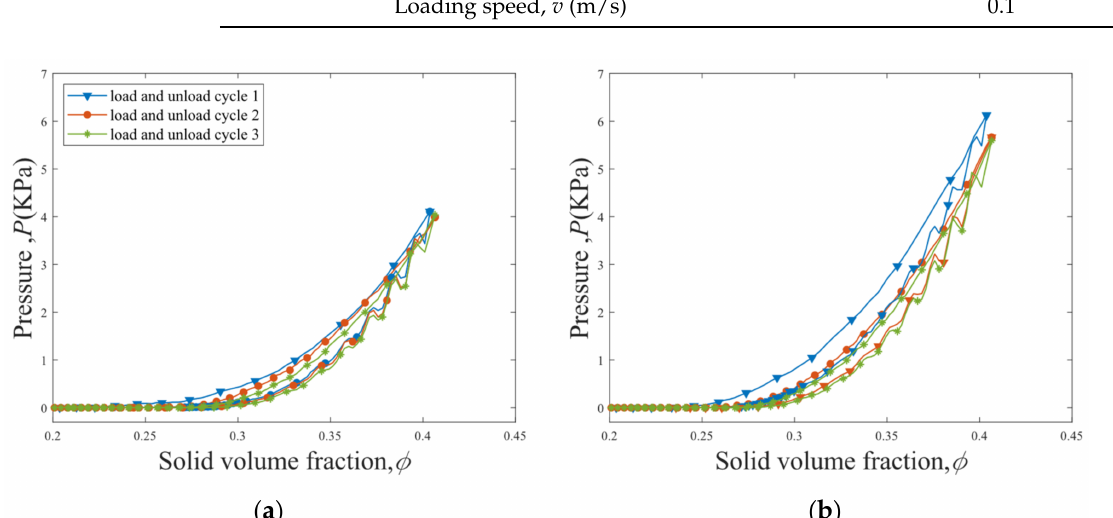
Figure 7. P − φ curves for the first three load–unload cycles of ( a ) straight fibers ( κ = 0 m − 1 ) and ( b ) S-shaped fibers ( κ = 100 m − 1